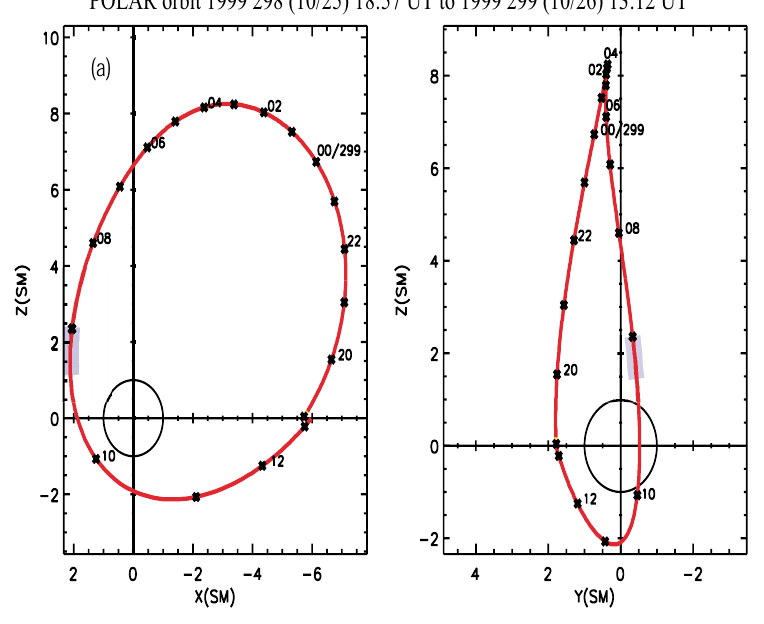
Fig. 5. (a) A section of the orbit described by the Polar spacecraft on 26 October 1999 expressed in a So- lar Magnetic coordinate frame. The shaded grey region indicates the inter- val where the ion distribution functions were derived from the onboard parti- cle detector CAMMICE (MICS). (b) (c) Ion distribution functions, f , de- rived from the CAMMICE (MICS) in- strument for the intervals (a) 09:00– 09:05UT and (b) 09:05–09:10UT. Dur- ing this time the spacecraft traversed L-shells 7.1–5.9 and